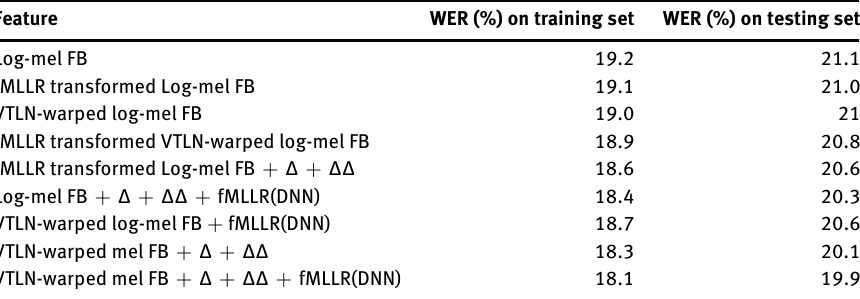
Table 6: WER as a Function of Input